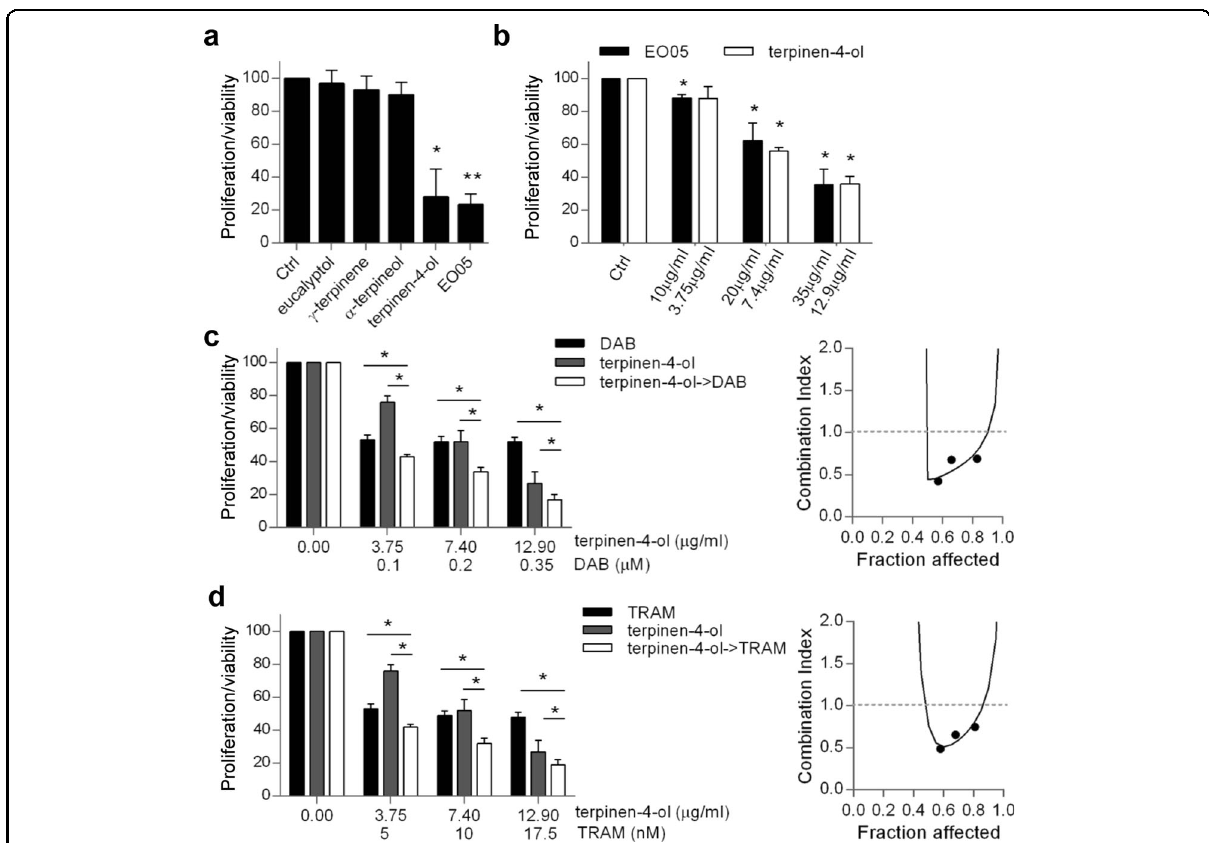
Fig. 5 Terpinen-4-ol is responsible for EO05 antitumor activity in M14 cells. a MTT assay of M14 cells treated for 72 h with eucalyptol (7 μ g/ml), γ -terpinene (6 μ g/ml), α -terpineol (4 μ g/ml), terpinen-4-ol (18.5 μ g/ml) or EO05 (50 μ g/ml). b MTT assay of M14 cells treated with the indicated concentrations of EO05 or of terpinen-4-ol. c , d MTT assay (left) and relative isobologram (right) of M14 cells treated with c dabrafenib (DAB), d trametinib (TRAM), or terpinen-4-ol alone or in combination (24 h terpinen-4-ol followed by 48 h DAB or TRAM). a – d The results are reported as “ cell proliferation-viability of treated cells/cell proliferation-viability of control cells × 100 ” . The results represent the average±standard deviation of at least three independent experiments. p -values were calculated between control (Ctrl) and treated cells or cells treated in combination and cells treated with single drugs. * p < 0.05; ** p < 0.01, after applying Student ’ s t